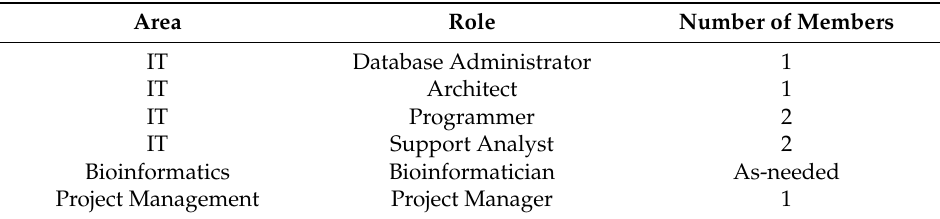
Table 4. Mayo Oracle TRC post-implementation